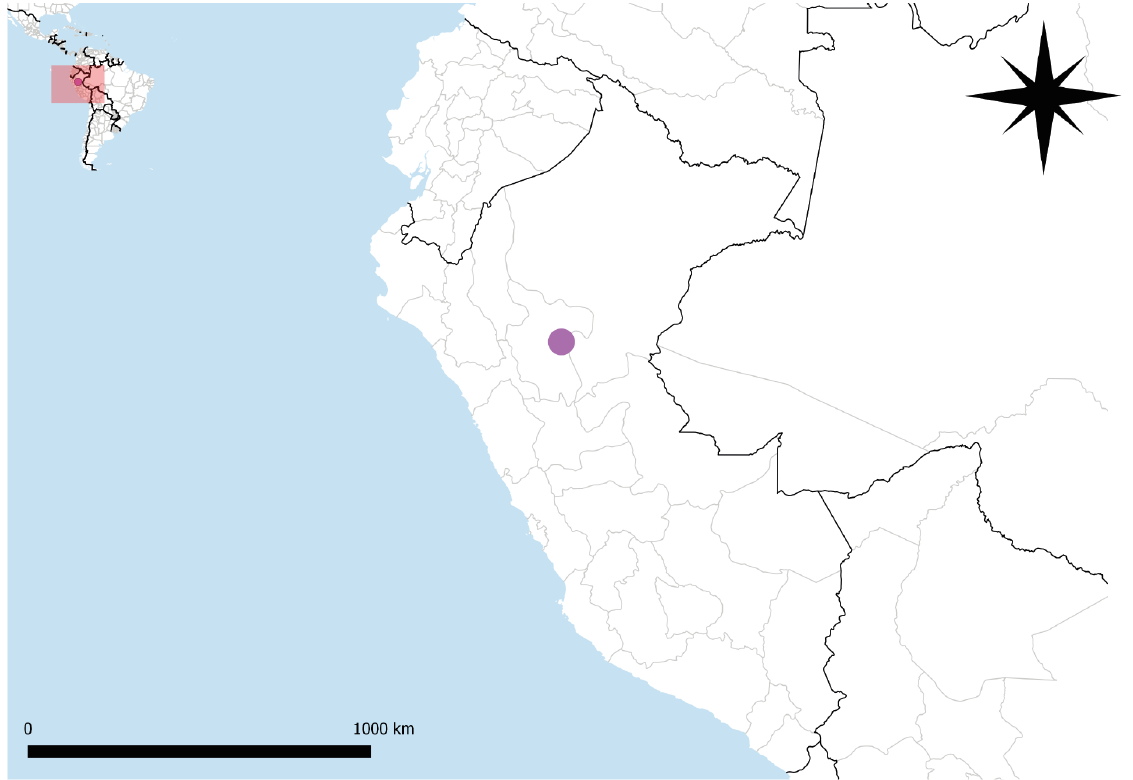
Fig. 5. Distribution (type locality) of Iviephengus ferreirai gen. et sp.